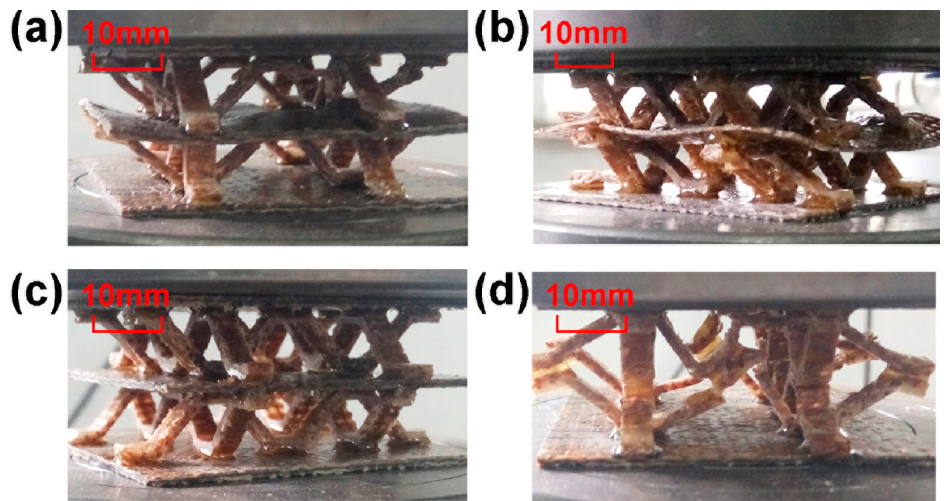
Figure 12. Deformation of test samples under pressure when ( a ) stacked in order ( t f 1 = 2.0 mm) ( b ) stacked in order ( t f 2 = 0.9 mm) ( c ) symmetrically stacked ( t f 1 = 2.0 mm) ( d ) symmetrically stacked but without the intermediate support plate.